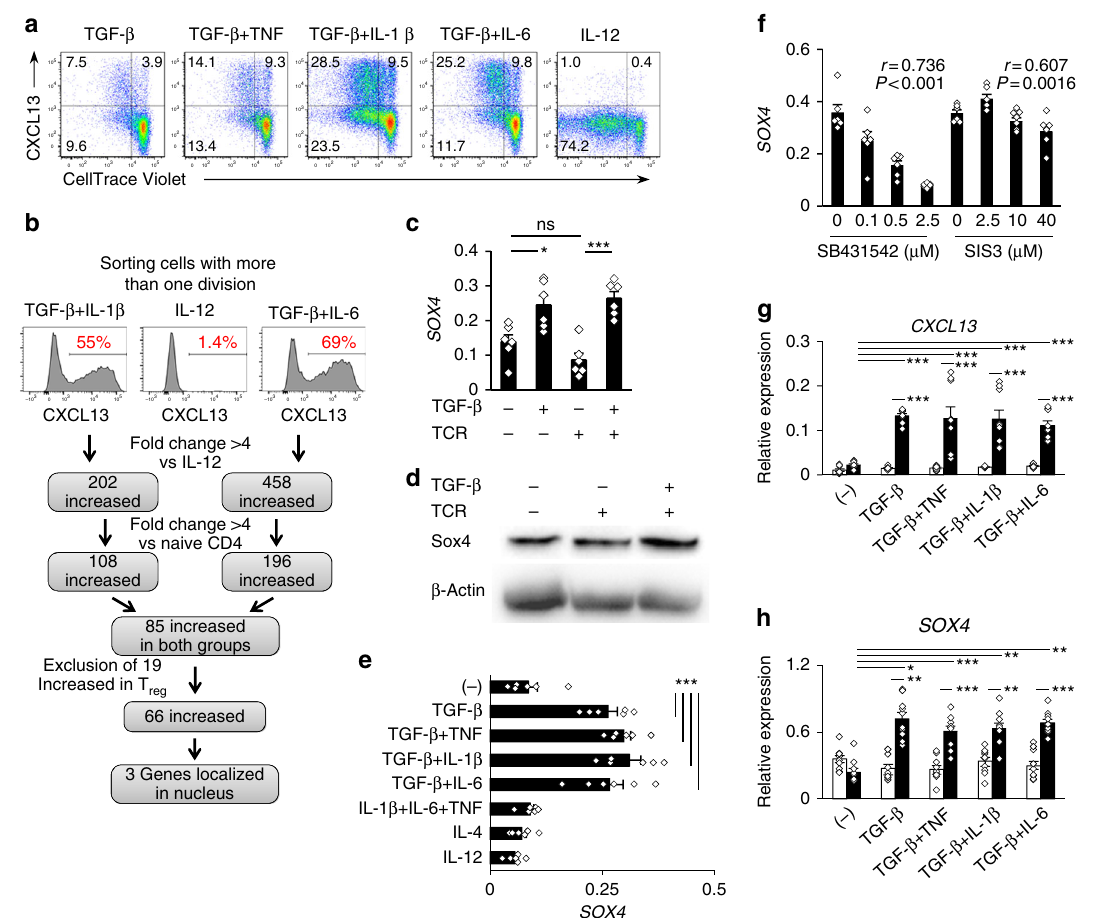
Fig. 2 Transcriptome analysis identi fi ed Sox4 as a transcription factor relating to CXCL13-producing CD4 + T cells. a Human blood CD4 + T cells labeled with CellTrace ™ Violet were differentiated in the presence of the indicated cytokines and neutralizing anti-IL-2 antibody for 5 days. Quadrants de fi ne CXCL13-positive/negative cells, and cells with 0 – 1 divisions and cells with ≥ 2 divisions. b Outline for the screening of candidate transcription factors. c , d Sox4 expression in human naive CD4 + T cells unstimulated or stimulated with anti-CD3/CD28 antibodies for 24 h in the presence of TGF- β was assessed by quantitative PCR ( c ) or immunoblotting ( d ). e , f Human naive CD4 + T cells were cultured with TCR stimulation in the presence of the indicated cytokines ( e ) or TGF- β plus a TGF signal inhibitor, SB431542, or a SMAD3 inhibitor, SIS3 ( f ) for 24 h. Relative SOX4 expression was measured by quantitative PCR. g , h Relative mRNA expression of CXCL13 ( g ) and Sox4 ( h ) assessed by quantitative PCR in naive human CD4 + T cells differentiated with TCR stimulation and the indicated cytokines in the presence (solid) or absence (open) of neutralizing anti-IL-2 antibody for 3 days. Cumulative data ( n = 6 from two experiments in c – e , and f ; n = 9 from three experiments in g , h ) are presented as corresponding dots and the mean ± SEM. * P < 0.05, ** P < 0.01, and *** P < 0.001 by one-way ANOVA, Tukey ’ s test, and r and P -values by Pearson ’ s correlation analysis. Numbers in fl ow cytometry plots indicate the percentage of cells in the indicated